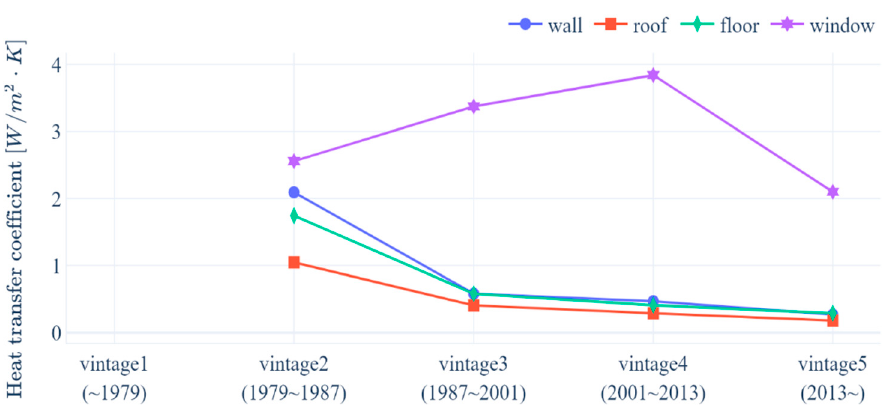
Figure 6. Insulation standards for each building part in vintage groups.